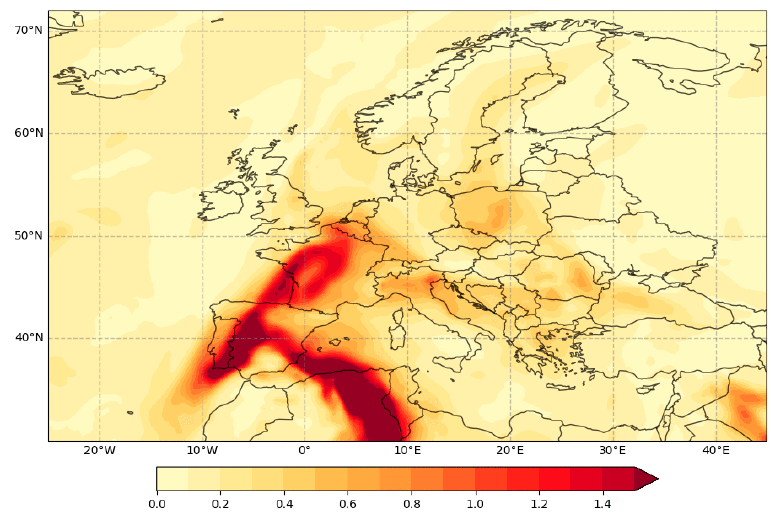
Figure 5. Aerosol model on 16 March 2022 from the Copernicus European program [32].